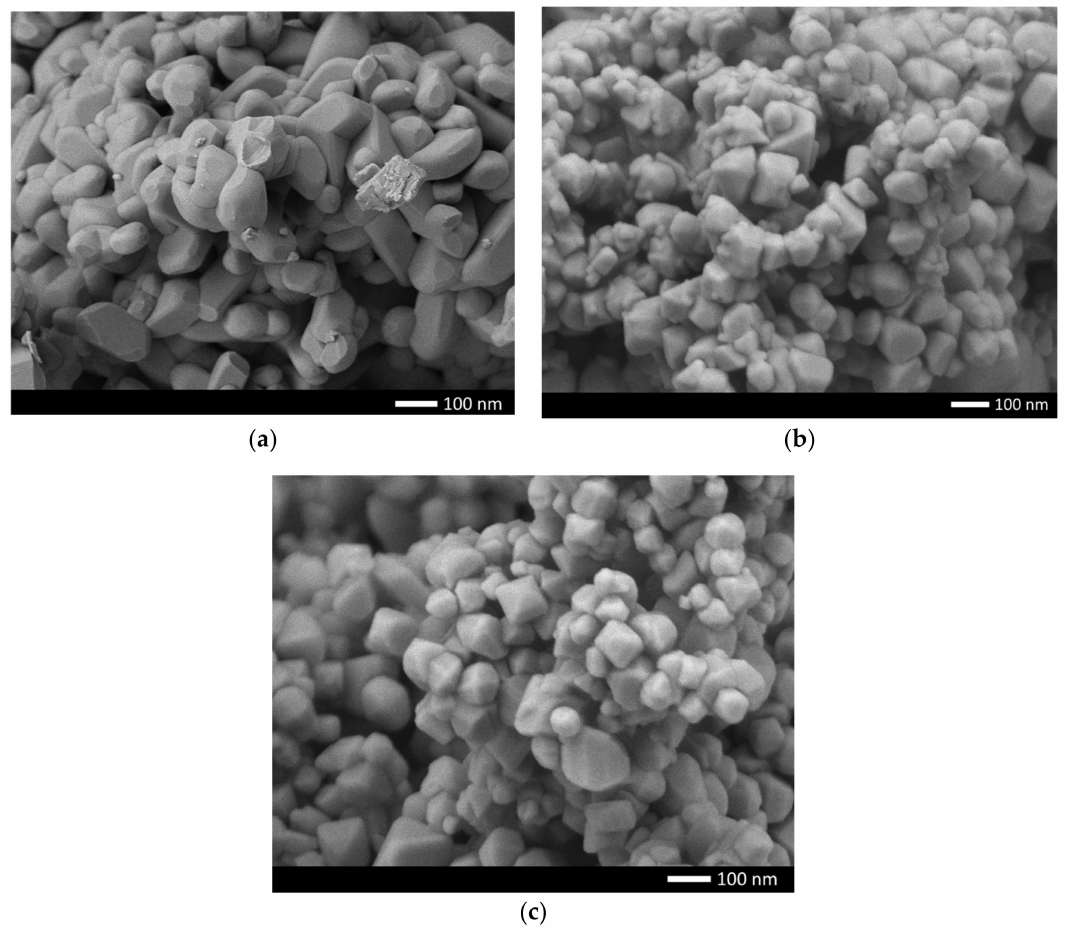
Figure 1. SEM images of the morphology of the synthesized ceramics: ( a ) pristine; ( b ) 0.10 mol; ( c ) 0.25